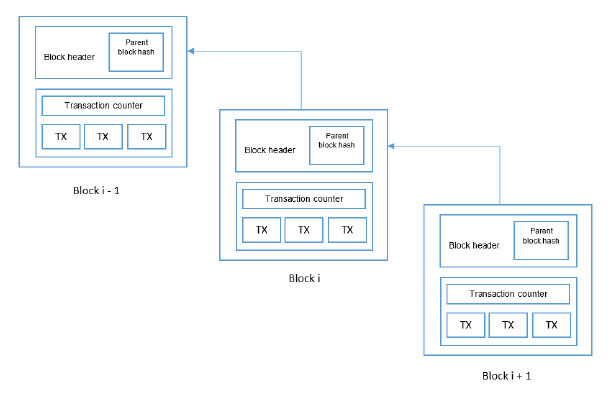
Figure 1. Block structure in a